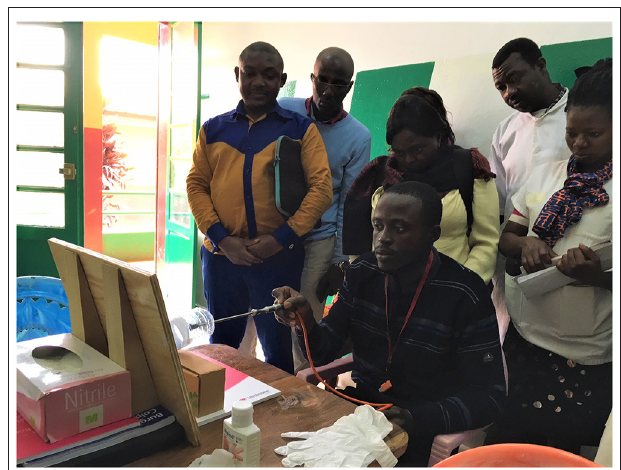
FIGURE 2 | Thermal ablation simulation at Dschang district hospital. HCPs become familiar with the equipment and competent at performing thermal ablation through the use of models. Polyvinyl chloride tubes (500 cc water bottle) with a diameter of approximately 5cm were used to simulate the vaginal canal and potatoes with a diameter of 2–3cm were used to simulate the cervix. The probe can be placed through the simulated vagina and applied to the simulated cervix. This type of model is widely accessible and useful in achieving clinical competence before performing the procedure on a